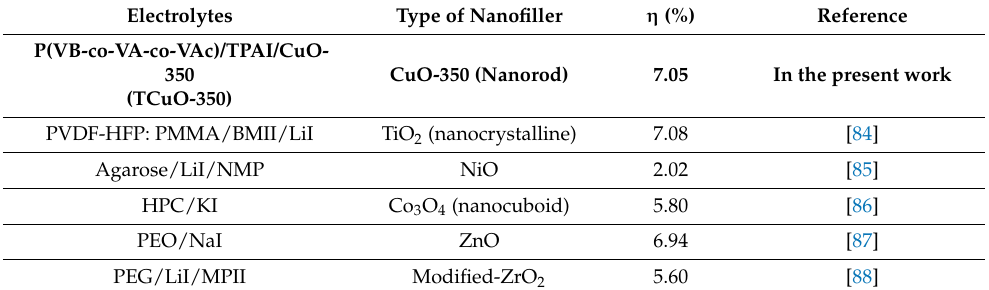
Table 4. Comparison of reported efficiency for transition metal oxide as nanofiller based PCGE used in the DSSC and TCuO-350.